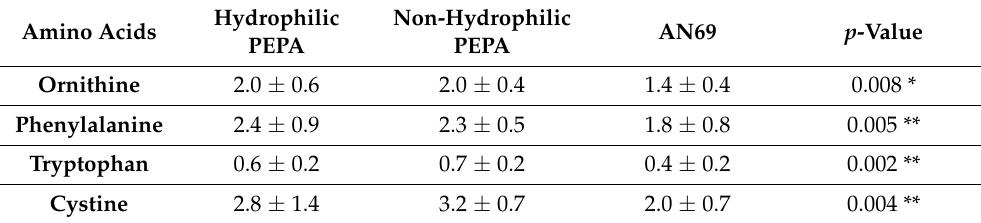
Table 3. Clinical Evidence on Benefits of AN69 in Inflammation, Malnutrition, and Peripheral Arterial Disease Associated with